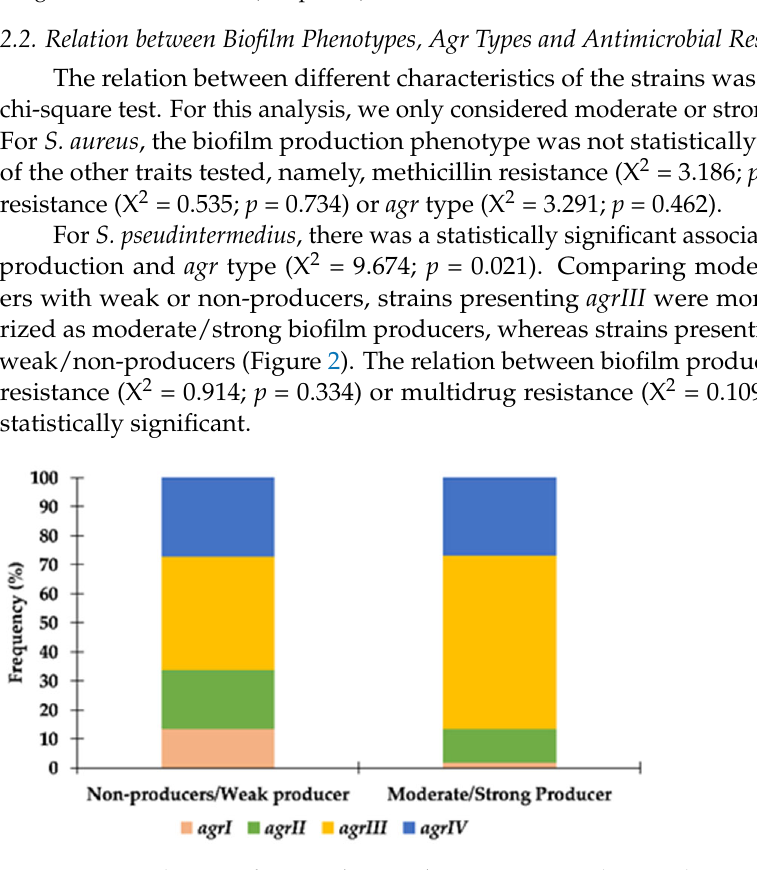
Figure 1. Effect of NaCl supplementation in biofilm production for the S. pseudintermedius (SP, n = 155), S. aureus (SA, n = 55) and S. coagulans (SC, n = 27) strains. Full-colored columns—TSB supplemented with 1% glucose (SA and SC) and 1% NaCl (SP); partially filled columns—TSB supplemented with 1% glucose and 3% NaCl (all species).